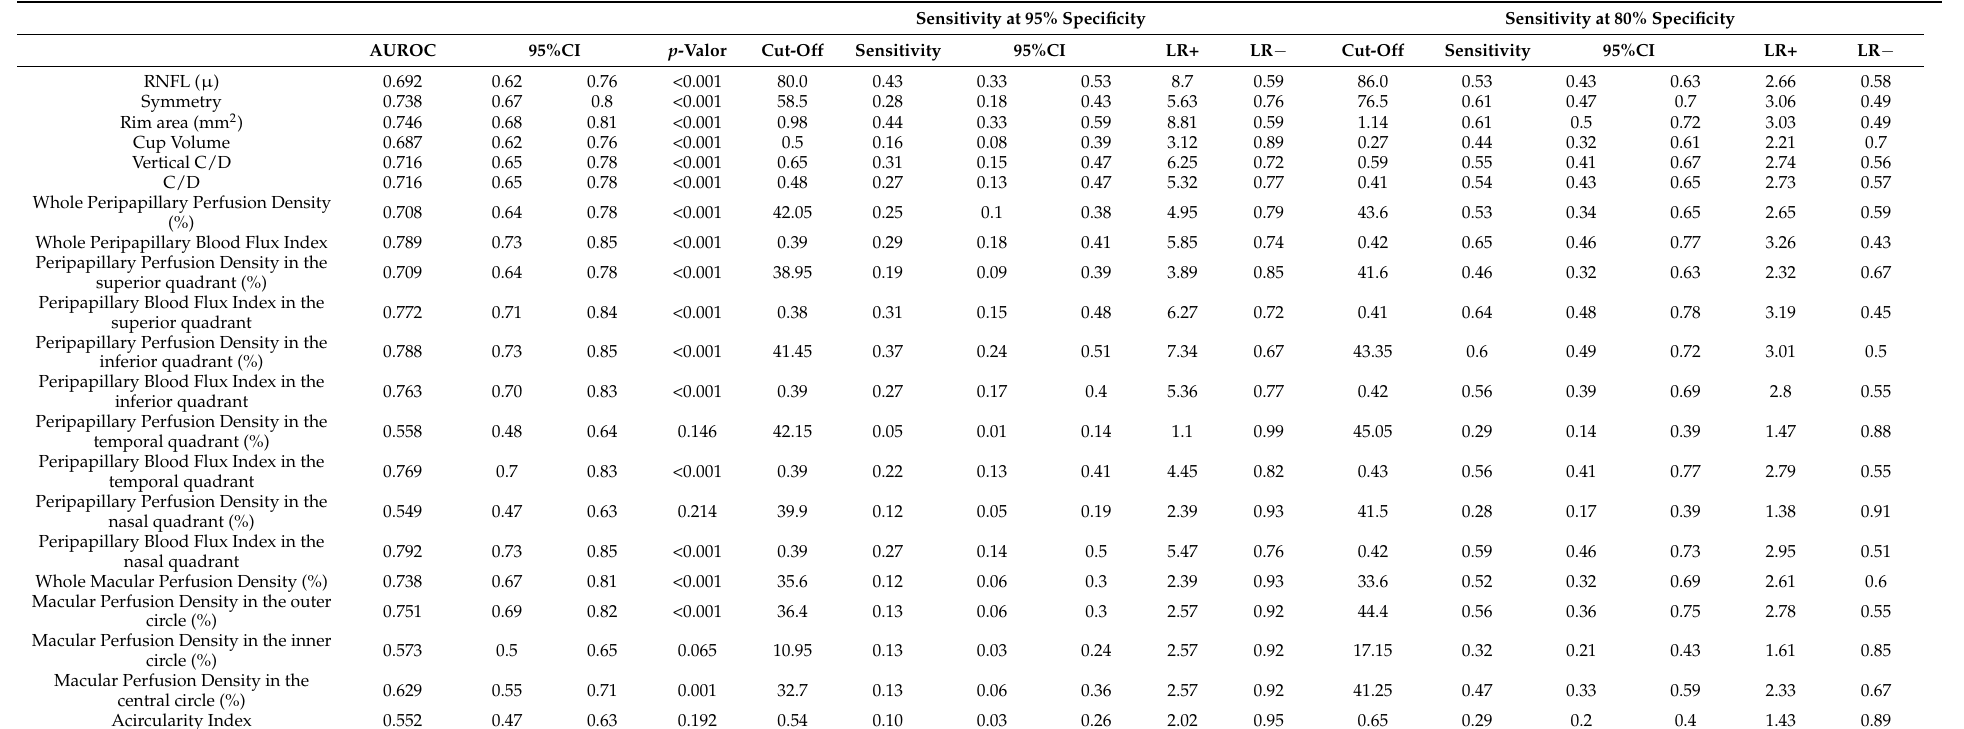
Table 5. Areas under receiver operating characteristic curves (AUROCs) for the variables measured using